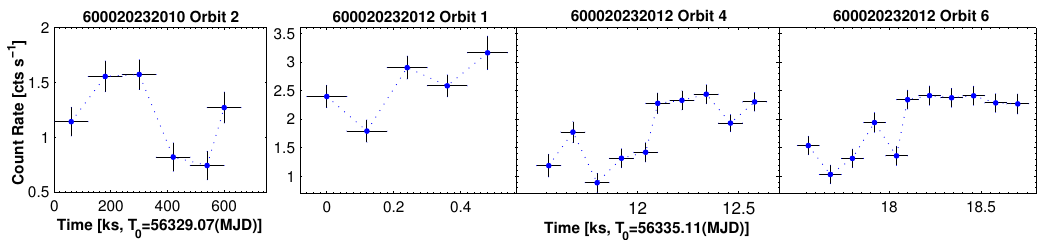
Figure 2. Very fast 3–79 keV IDVs in Mrk421 from the NuSTAR observations performed on 6 February 2013 ( first panel ) and 12 February ( second , third and fourth panels ).